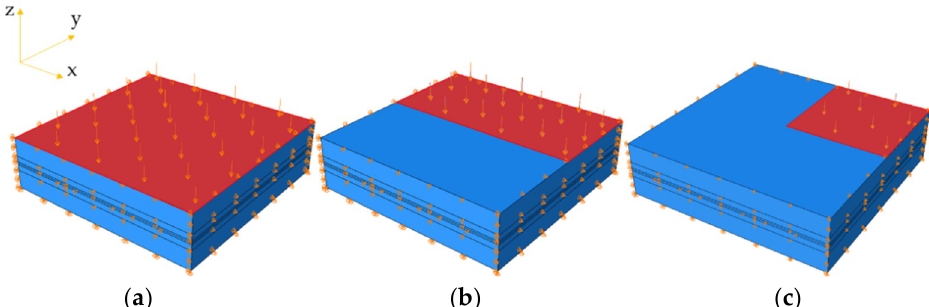
Figure 8. Loading modes on the PEH: ( a ) full loading; ( b ) half loading along y-direction; ( c ) quarter loading.